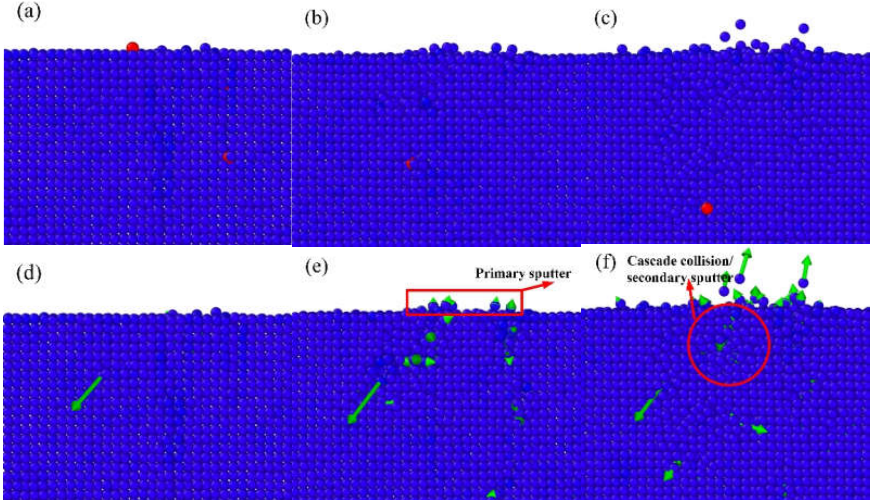
Figure 3. Scheme of Ar ion implantation, ( a – c ) process of implantation, ( d – f ) corresponding motion of Al atoms.